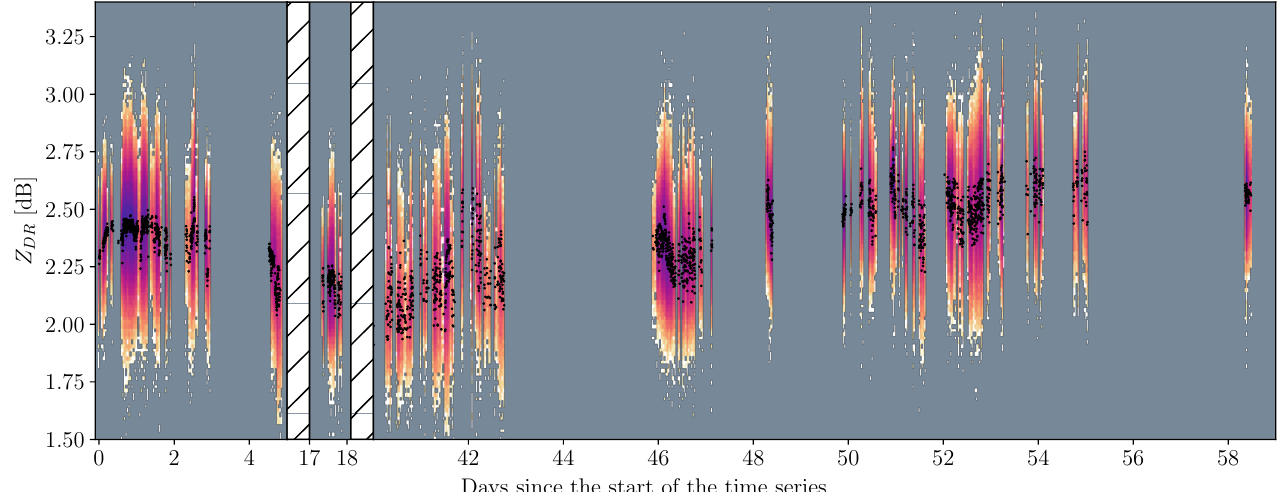
Figure 2. The 2-dimensional histograms of the accepted couples ( t , Z DR ) at the end of Section 3.1. The color scale shows the logarithm of the measurements counts per bin. The black dots represent the ˜ g Z of each scan. Due to the absence of measurements, the intervals DR ( 5,17) days and (18, 40) days are removed from the plot. In their place, to show the interruptions in the time series, two vertical hatched patches are